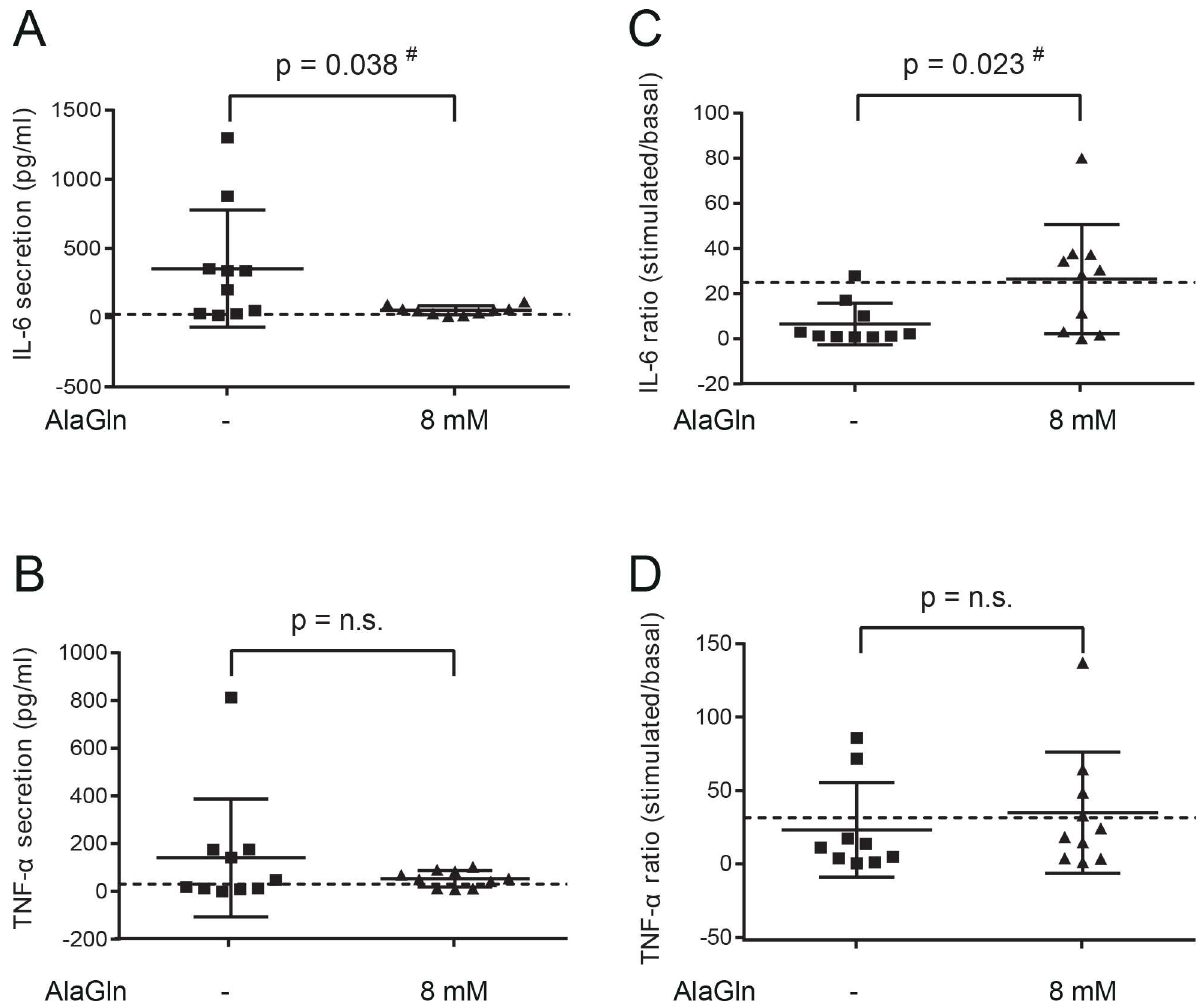
Fig 7. Inflammation and immuno-competence in the mouse model of PD- associated peritonitis. Mice were subjected for 9 days to twice-daily intraperitoneal PDF injection, in combination with 10 7 cfu Staphylococcus epidermidis on days 2 and 4. PDF was applied with (N = 10) or without (N = 10) added 8 mM AlaGln. Control mice (N = 4) received no treatment. As shown in Panel A and B, basal levels of IL-6 and TNF- α in peritoneal effluents were lower in the group treated with AlaGln than in the group treated without it, although not statistically significant, when p-values were Bonferroni-corrected for testing two outcomes. Values of controls are shown as dashed line. Ex-vivo LPS stimulation (10 ng/ml; 4 h) of peritoneal cells resulted in increasedIL-6 and TNF- α release in control animals (ratio of stimulated/unstimulated is shown as dashed line C and D). Ex-vivo stimulated release of IL-6 and TNF- α was depressedin the group without AlaGln and restored in the group with AlaGln (raw p = 0.023 vs . without AlaGln for IL-6; Bonferroni-corrected p = 0.046). Data are shown as individualpoints (each representing an animal), means and standard errors. # P-values in the figure are given unadjustedfor multiple